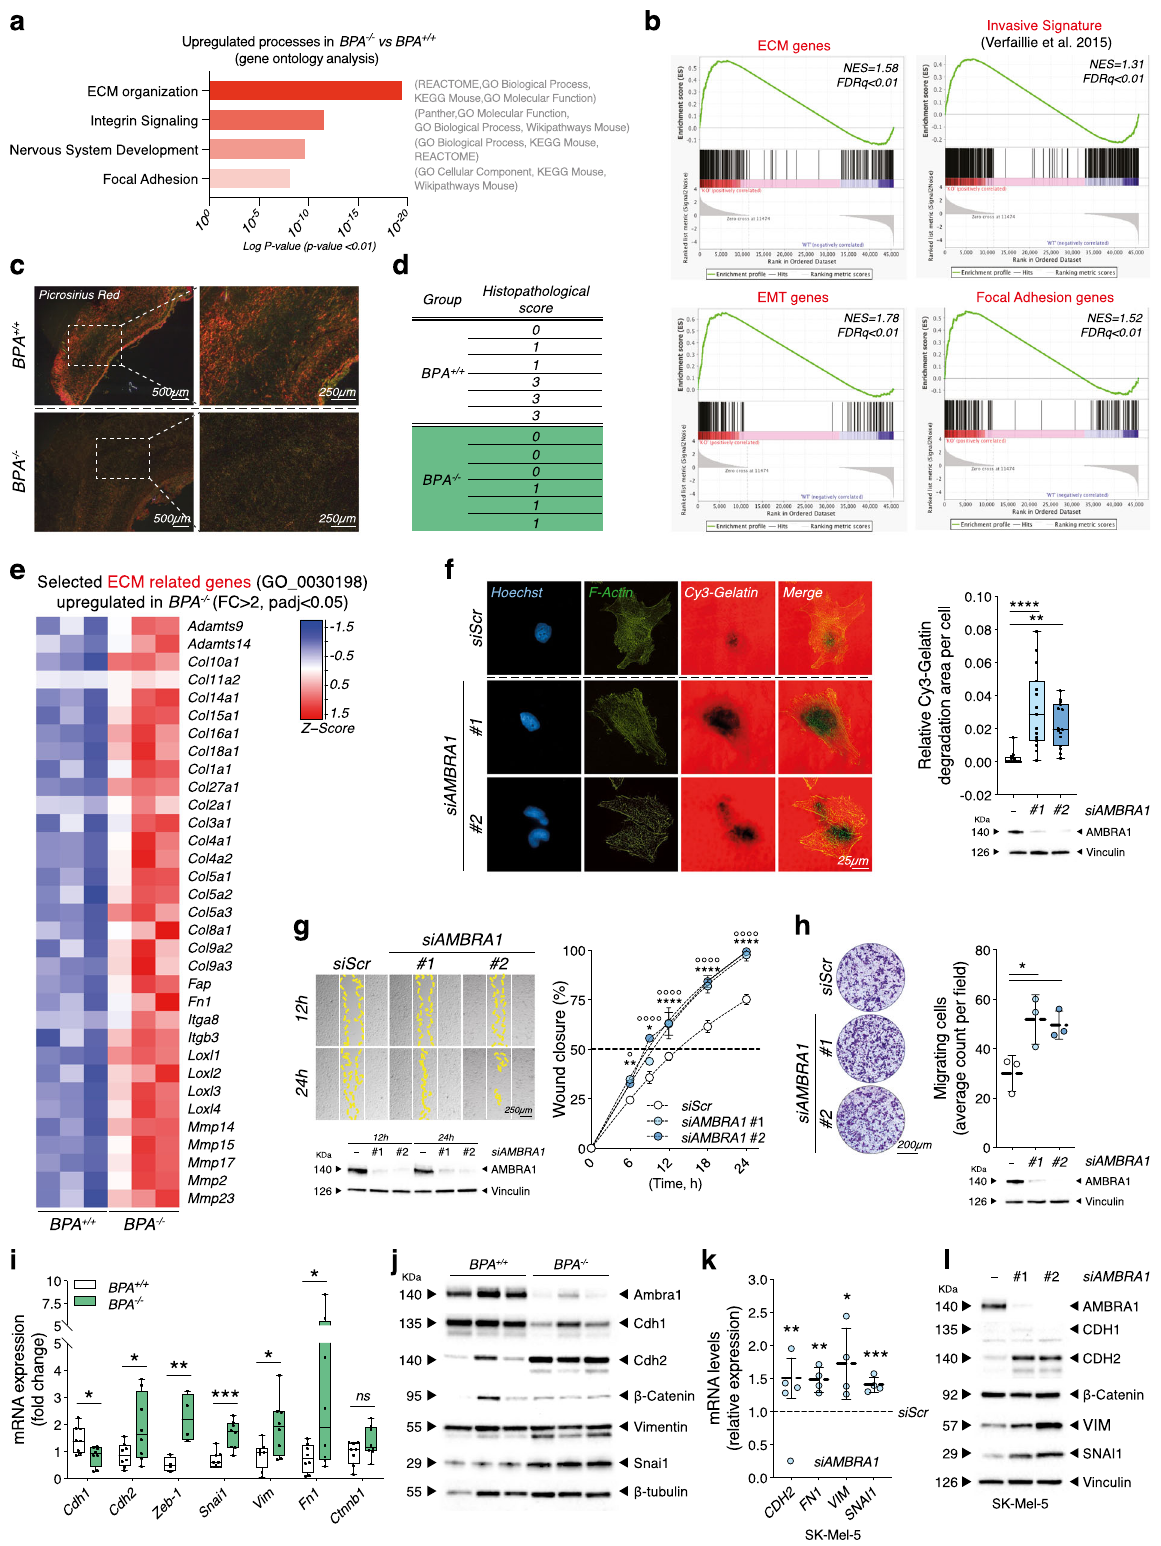
thick con fl uent collagen fi bers, similar to the normal reticular dermis, areas where the thick collagen fi bers were isolated and separated by a thin and fi brillary stroma, and areas with only thin fi brillary stroma. Histopathological analyses revealed that BPA − / − melanomas had a predominant fi ne fi brillar stroma, whereas BPA + / + tumors more often displayed longer and